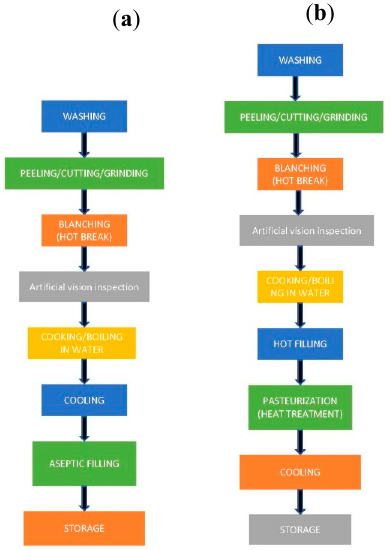
Figure 2. Flow-chart of processing vegetable soups packed using aseptic filling ( a ) or hot filling ( b ).